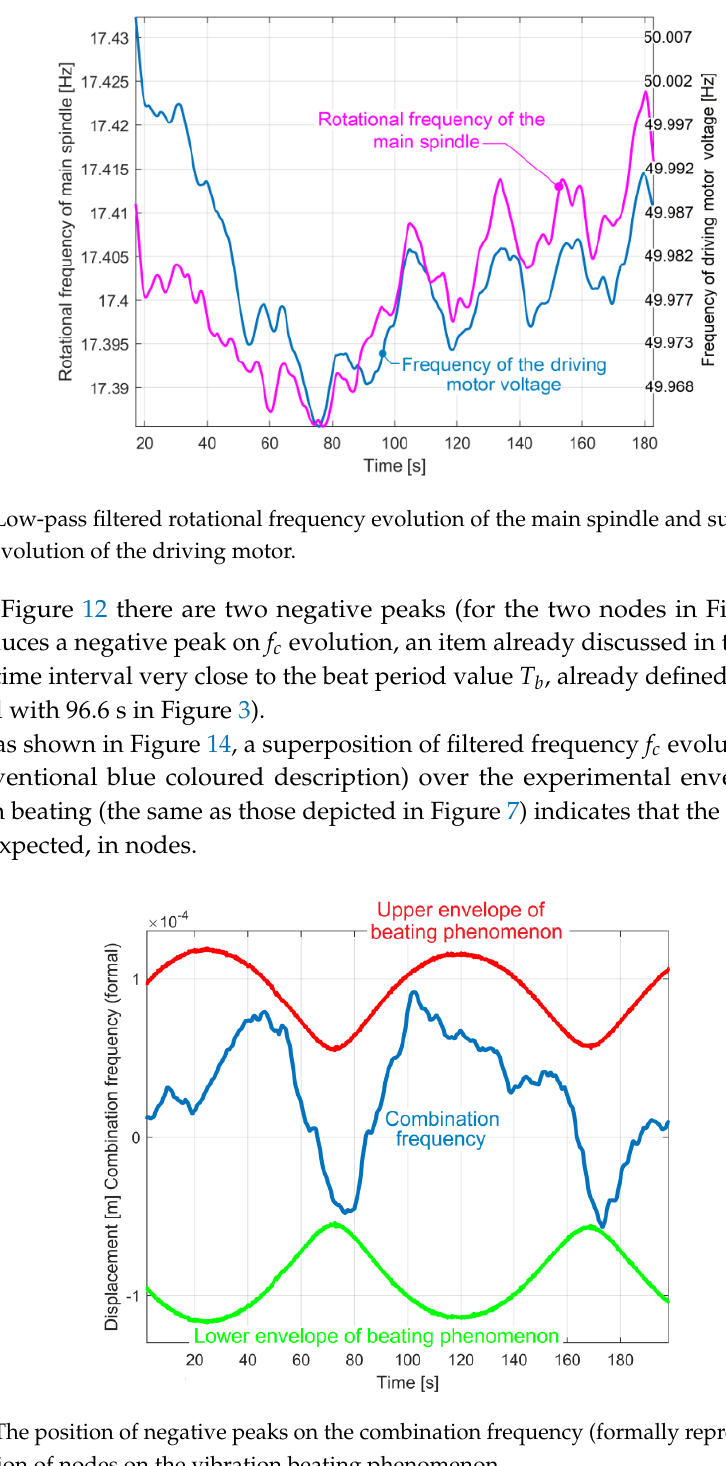
Figure 14. The position of negative peaks on the combination frequency (formally represented) relative to the position of nodes on the vibration beating phenomenon. to the position of nodes on the vibration beating